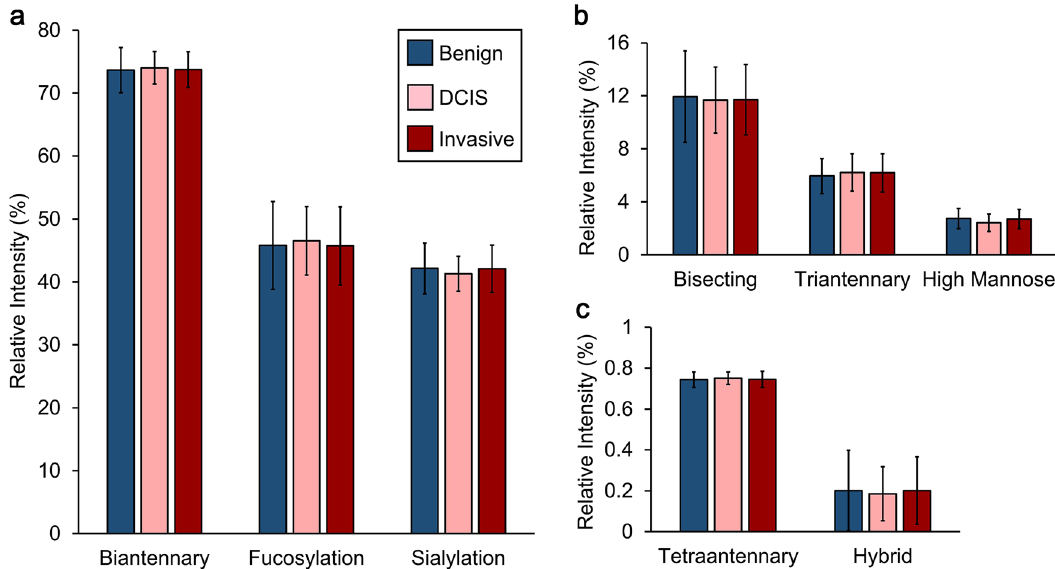
Figure 2. N-glycan class intensities of serum samples with benign lesions, DCIS, and invasive breast cancer. ( a ) High, ( b ) medium, and ( c ) low intensity serum N-glycan classes of benign, DCIS, and invasive samples. Data was analyzed by linear regression modeling of log-transformed relative intensities controlled for age, ethnicity/ race, and BMI to identify differences across disease status. Using a 5% false-discovery rate, no significant associations were